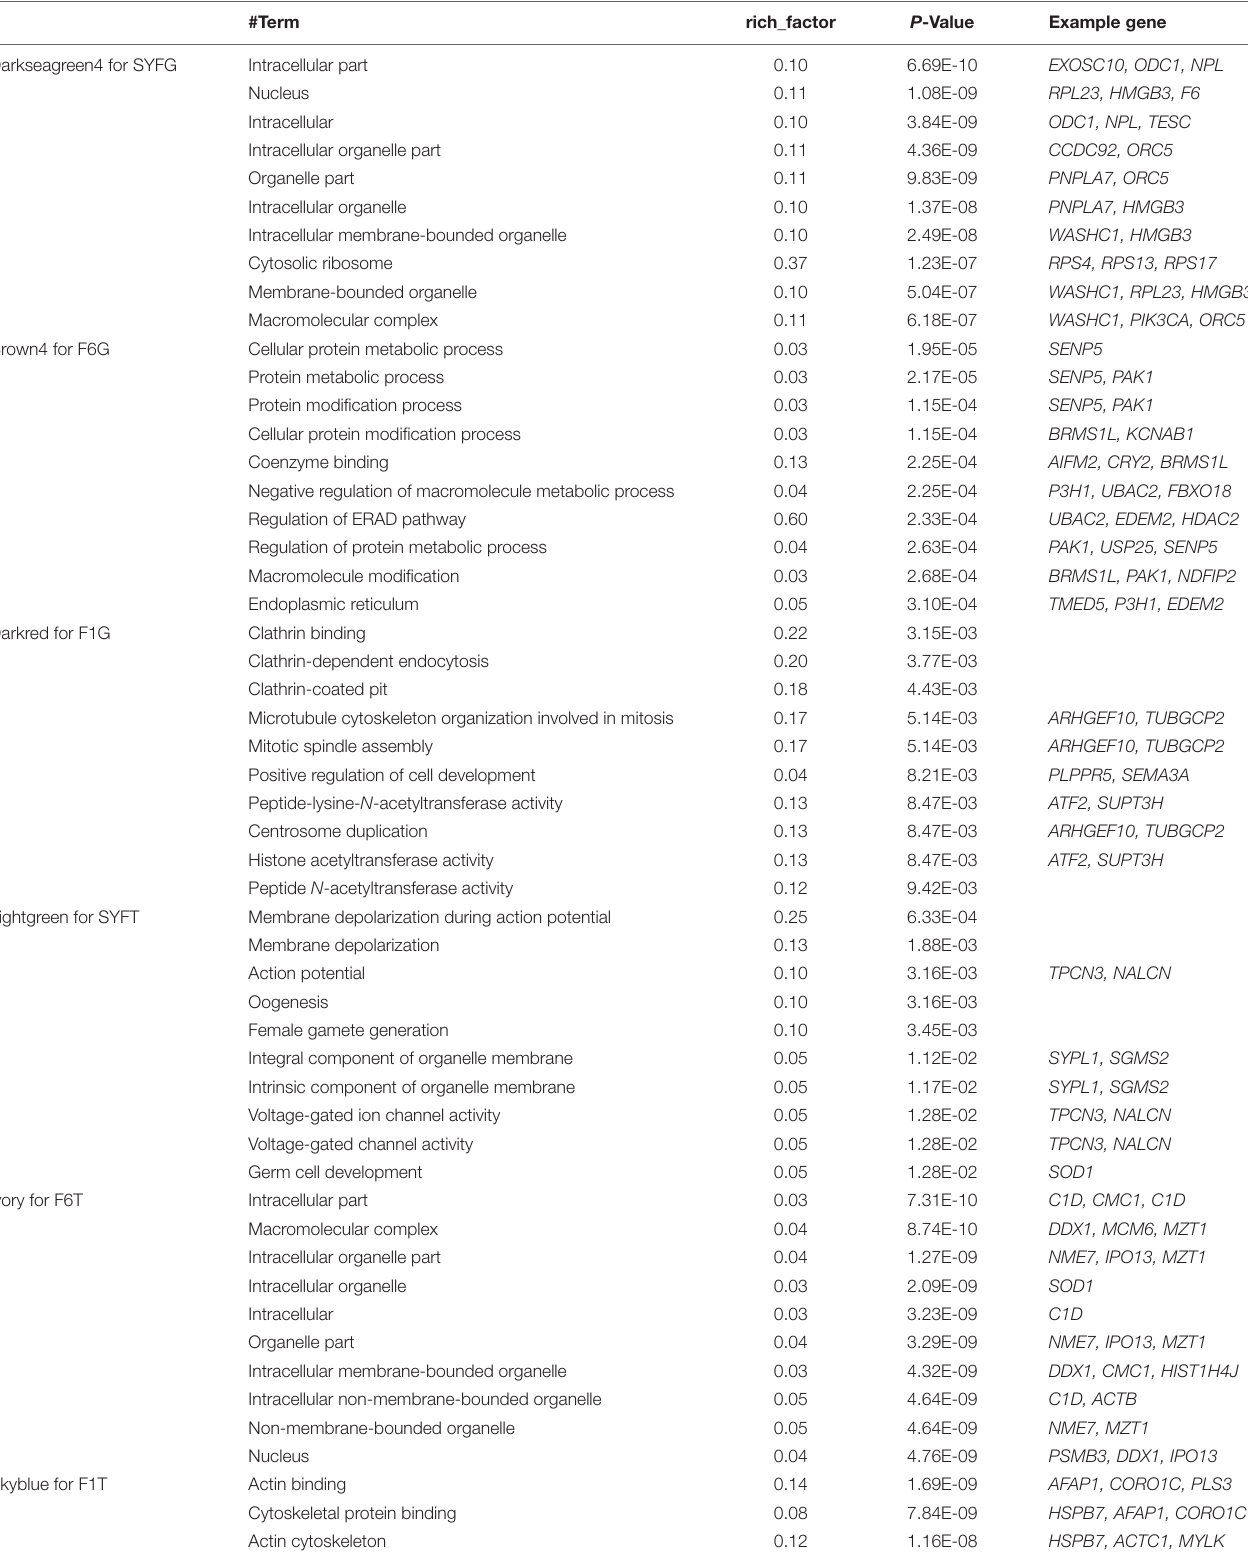
TABLE 4 | Top 10 GO terms of hub genes in different specific modules. #Term rich_factor P -Value Example gene Darkseagreen4 for